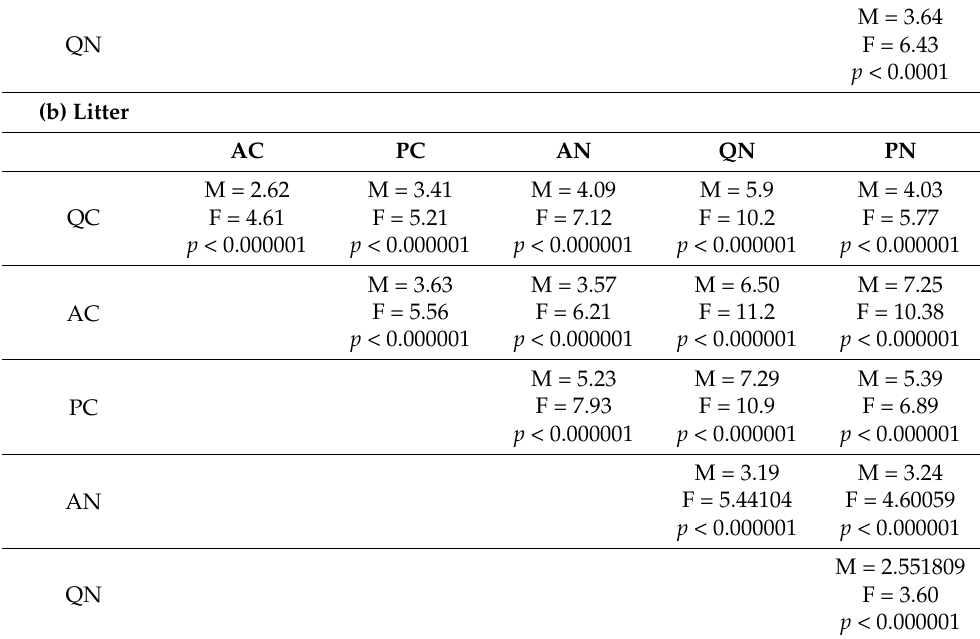
Figure 6. GDA results representation of root 1 and 2. Vectors representing variables, and ellipses representing control and N-fertilized plots measurements. ( a ) Leaves data. ( b ) Litter data. 3.6. Drought Effects All species have differences in control plots elemental composition between 2014 and 2015 in foliar tissue and respond similarly to drought. In foliar tissue, all macro-nutrients decrease significantly in 2015 in all three studied species except C in P. latifolia , which have no significant differences. In foliar micro-nutrients, Mg and Cu decrease significantly in 2015 in all three species, Ca increases significantly in P. latifolia and Q. ilex ; Cr and Ni decreases in A. unedo and Q. ilex ; Mn and Sr increase significantly in all three species; Fe decreases in A. unedo , increases in Q. ilex and has no differences in P. latifolia ; Zn decreases